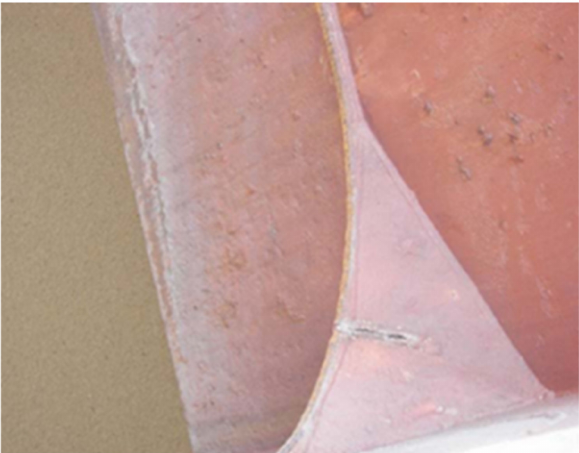
Figure 1. A fatigue crack in the hatch corner of a certain